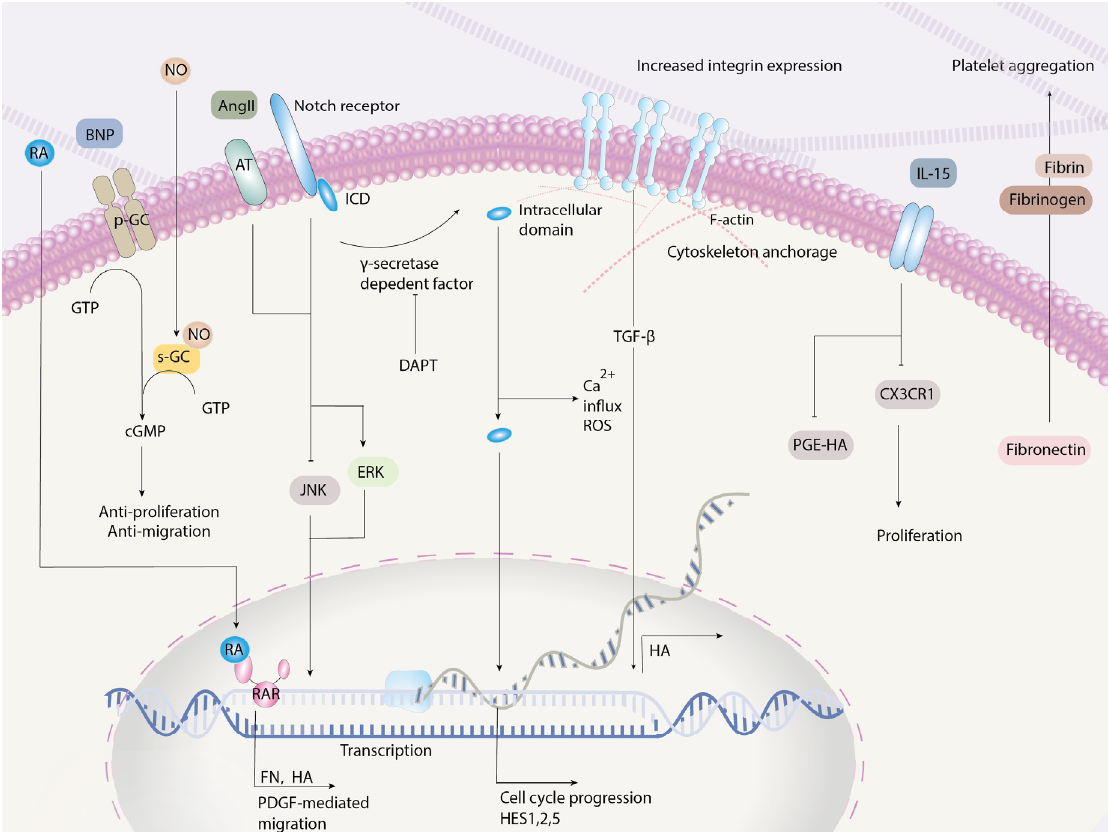
Figure 2. Molecular pathways of SMC-mediated migration and proliferation. The Notch system, upon secretase-dependent factor cleavage, releases the intracellular domains. The intracellular domains mediate ROS production, calcium influx, and ERK1/2 signaling, and act as transcription factors promoting cell cycle progression. TGF- β -mediated integrin expression increases anchorage to the SMC cytoskeleton and inhibits migration. Fibronectin is only effective when coupled with fibrin and fibrinogen, where the absence of fibrin and fibrinogen inhibits platelet aggregation and leads to a patent ductus. RA = retinoic acid; RAR = retinoic acid receptor; AngII = angiotensin II; AT = angiotensin receptor; MAPK = mitogen-activated protein kinases; ERK = extracellular regulated kinase; JNK = c-Jun N-terminal kinase; ICD = intracellular domain; PGE-HA = prostaglandin-induced hyaluronic acid production; PDGF = platelet-derived growth factor; FN = fibronectin; HA = hyaluronic acid; HES = hairy and enhancer of split; DAPT = N-[N-(3, 5-difluorophenacetyl-L-alanyl)]-S-phenylglycine t-butyl ester; TGF β = transforming growth factor-beta; ROS = reactive oxygen species; IL = interleukin; NO = nitric oxide; BNP = B-type natriuretic peptide; pGC = particulate guanylyl cyclase; sGC = soluble guanylyl cyclase.